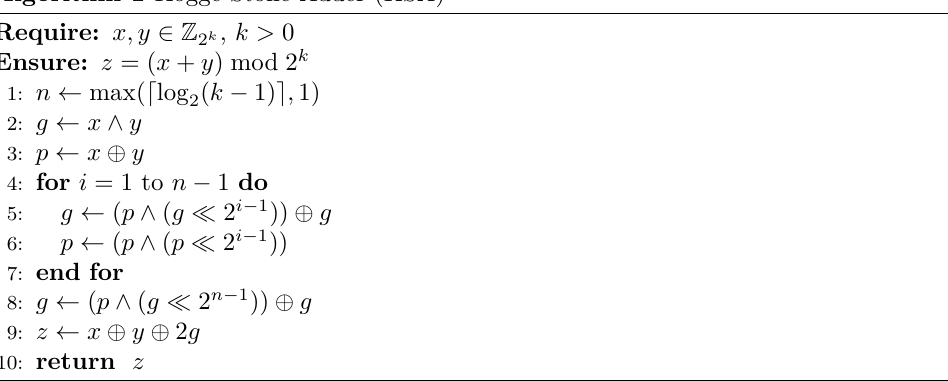
Algorithm 1 Kogge-Stone Adder